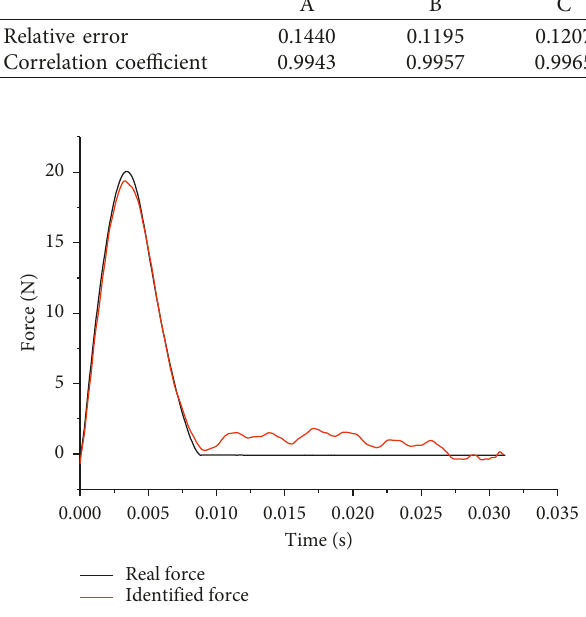
Figure 19: The reconstruction of the impact A.